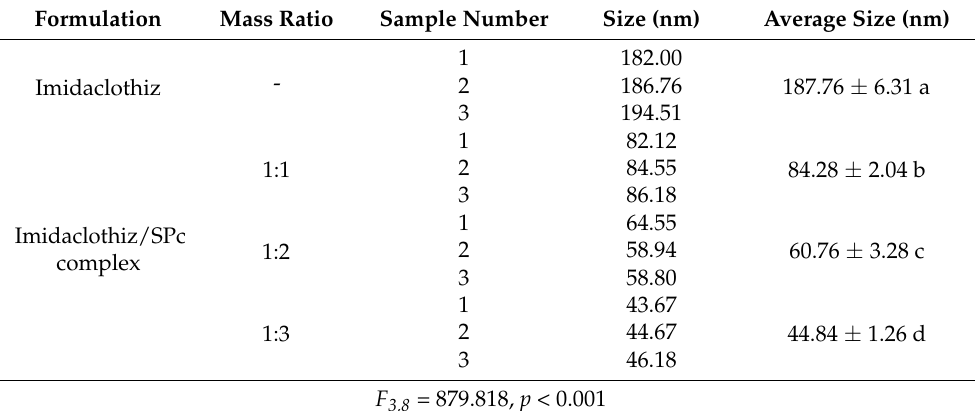
Figure 2. TEM images ( A ) and particle size distributions ( B ) of imidaclothiz and imidaclothiz/SPc complex at the mass ratio of 1:1. Table 1. Reduced particle size of SPc-loaded imidaclothiz at various mass ratios.